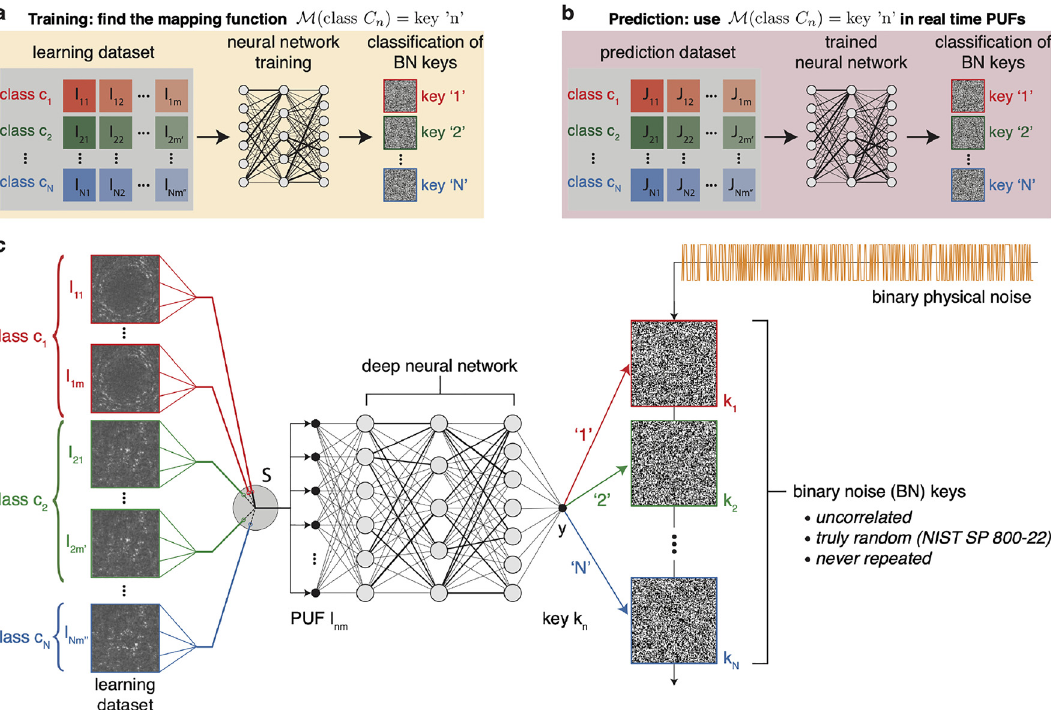
Figure 2: Two-step random key generation via deep learning. (a – b) Overall process for the training (a) and prediction (b) of key classi fi cation and association with PUFs. (c) Detailed schematic work fl ow of the training procedure: a switch S selects a PUF I nm at the input belonging to single classes c n (red, green, and blue colors). Each class is mappedbyadeepneuralnetworktoadifferentintegernumber n =1, … , N attheoutput y ,witheachnumberidentifyingabinarynoise(BN)key k n . The space of different keys is generated independently by fi rst sampling binary noise (orange solid line) and then splitting the